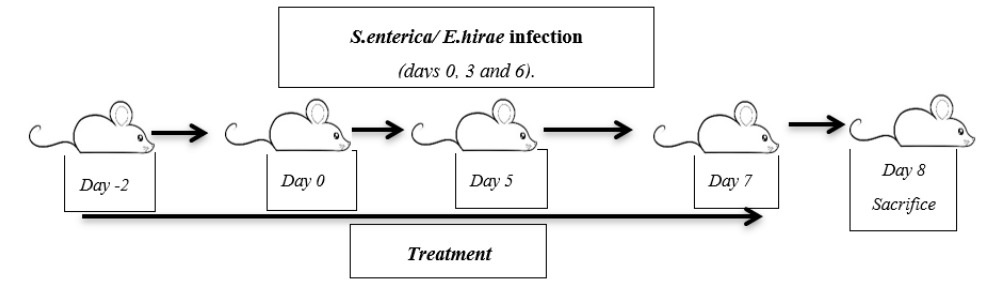
Figure 9. Schematic representation of the S. enterica and E. hirae infection model.